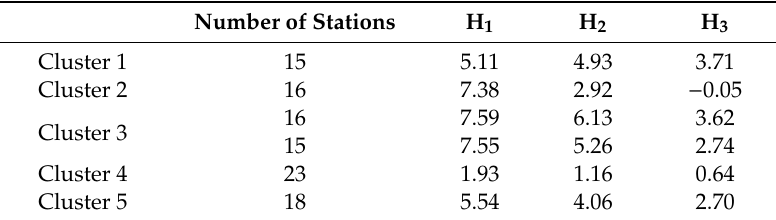
Table 8. Heterogeneity measures for each